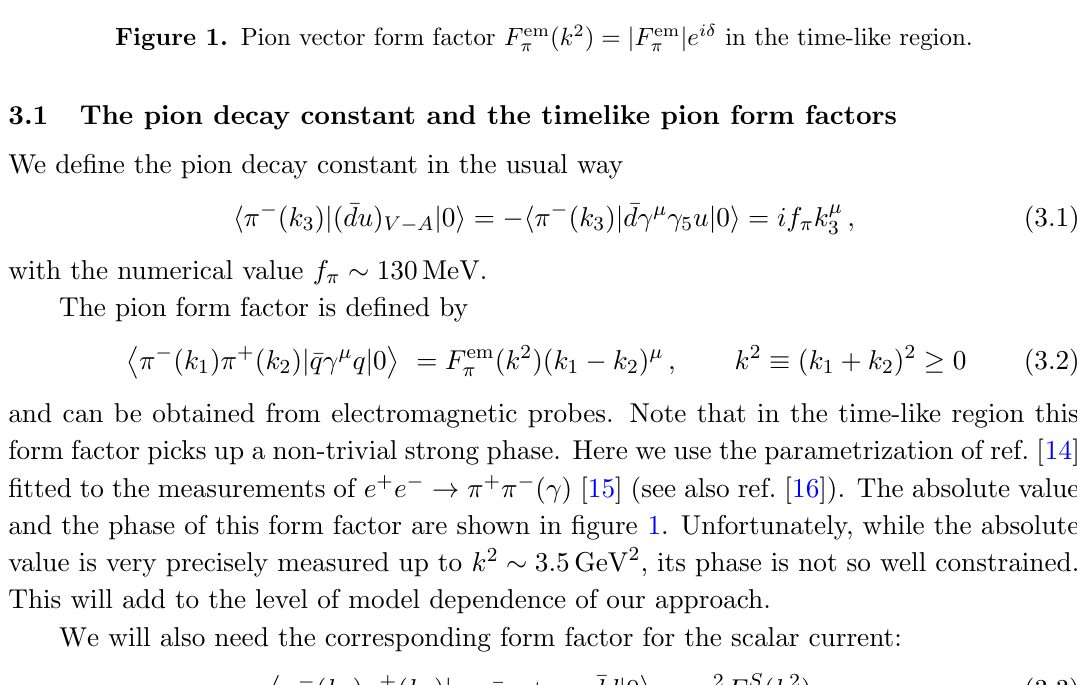
Figure 1. Pion vector form factor F em